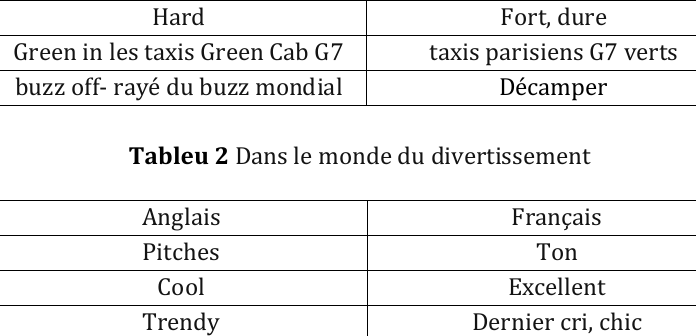
Tableu 1 L'anglais remplace le français dans le monde des affaires Anglais Hard